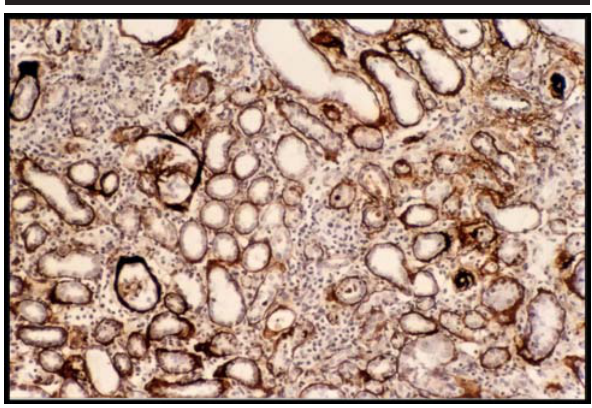
FIGURE 3 - Tubular atrophy and intense interstitial infiltrate. Kidney from GI at the time 3 (21 days). PASM, 100 X.